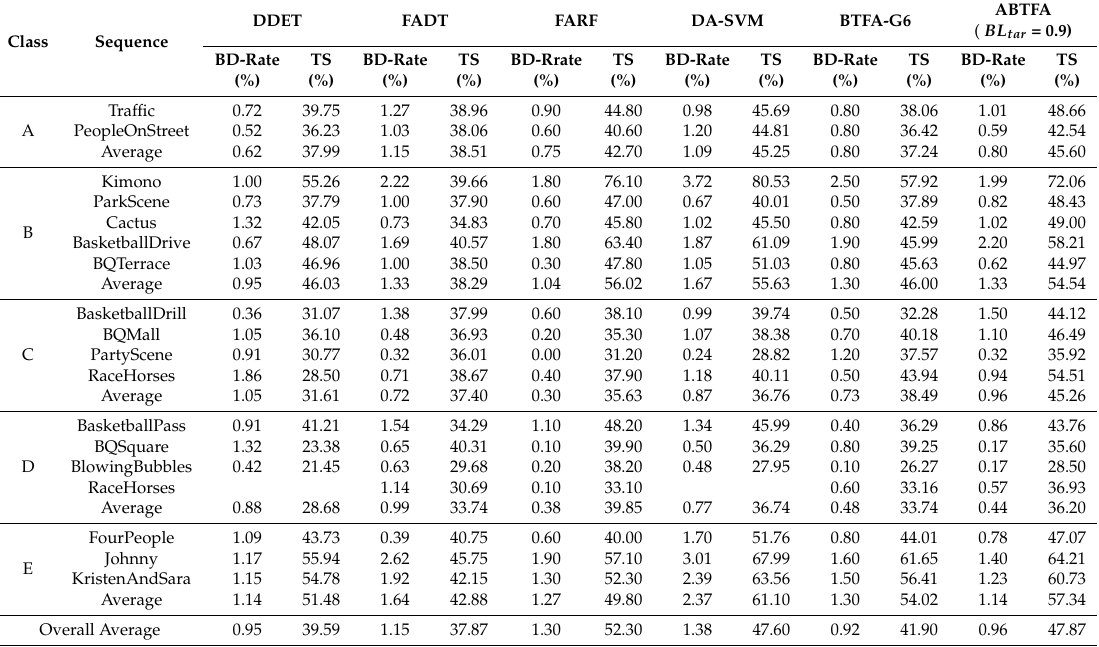
BD-rate loss and time saving comparison between the proposed BTFA, ABTFA and